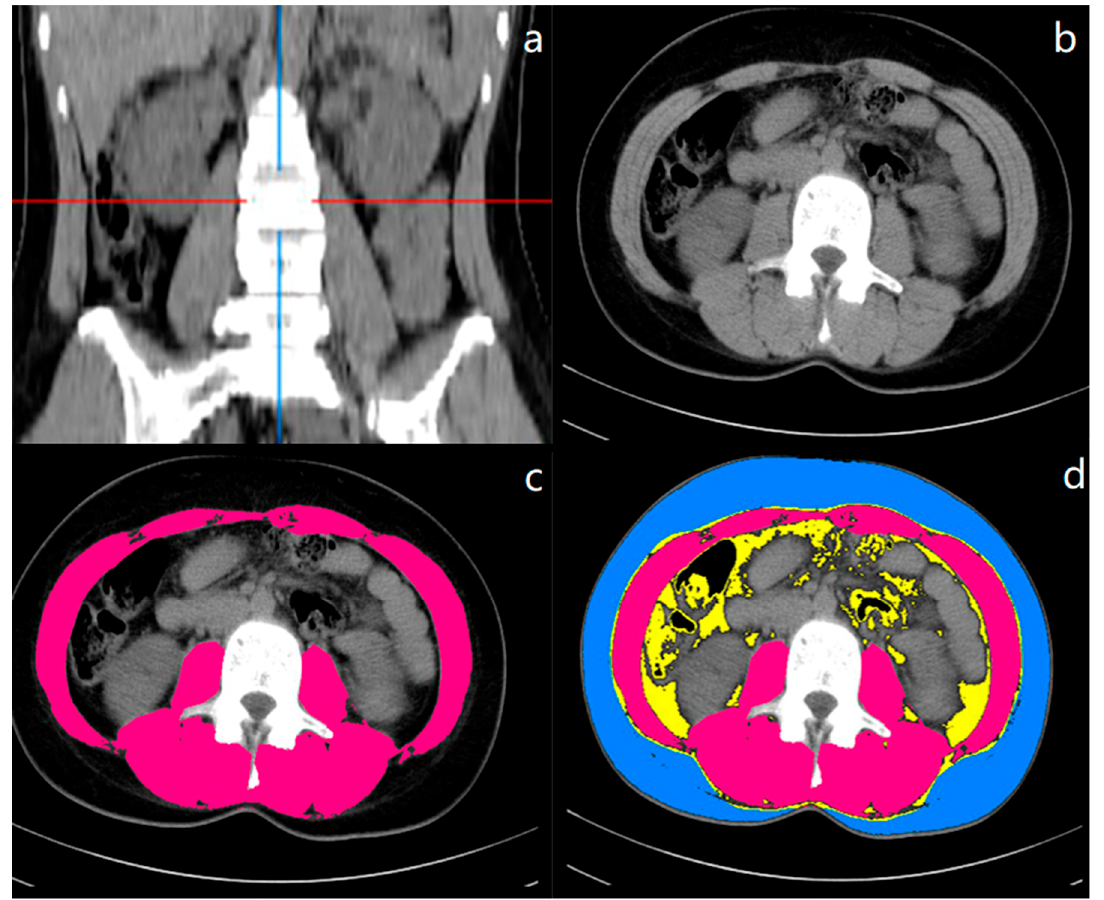
Figure 2. CT measurement of body composition at the level of the third lumbar vertebra (L3). ( a ) represented the coronal image and the red and blue lines identified the level of L3 and median coronal dividers, respectively. ( b – d ) represented the cross-sectional images. In the ( c , d ) images, different body composition areas were distinguished by different colors (blue: subcutaneous adipose tissue area; red: skeletal muscle area; the yellow area within the inner wall of the muscle: visceral adipose tissue area).